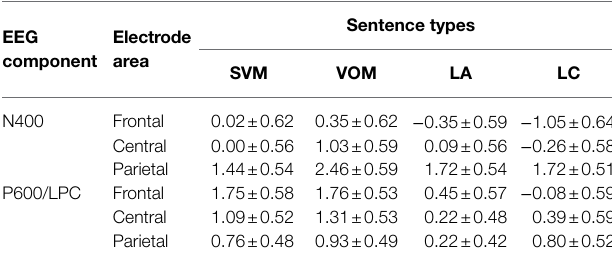
TABLE 3 | Mean amplitude ( μ V ) and standard deviation ( SD ) of N400 and P600/ LPC for target